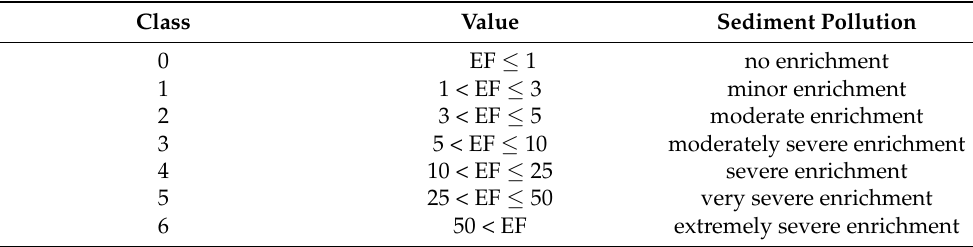
Table 2. Enrichment Factor (EF)